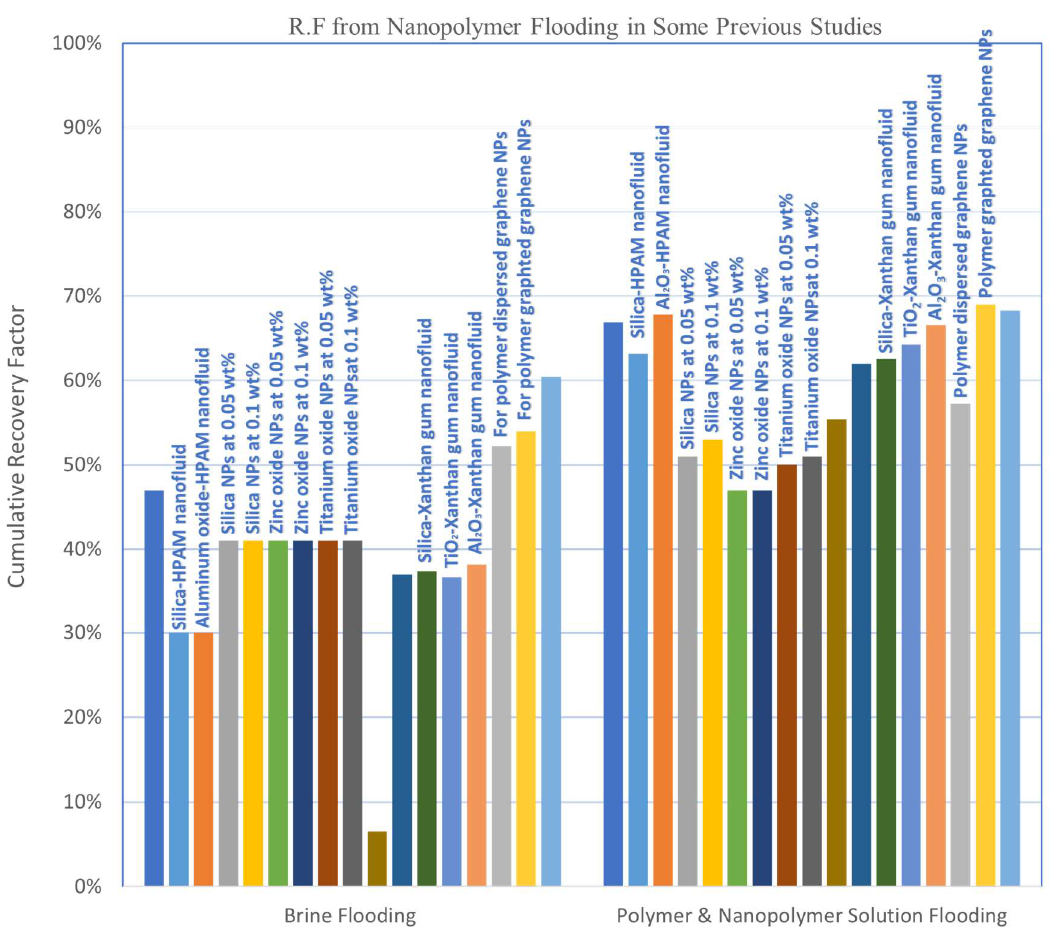
Figure 10. A summary of recovery factor results for some studies that integrate NPs in polymer EOR (Data obtained from the following references: [25,32,93–98]). (Data obtained from the following references: